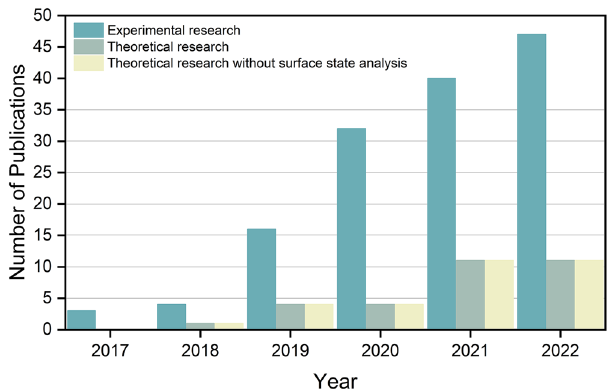
Fig. 1 Statistics of DAC research. The number of experimental and theoretical reports on dual-atom electrocatalysts during the past 6 years. Data summarized from Web of